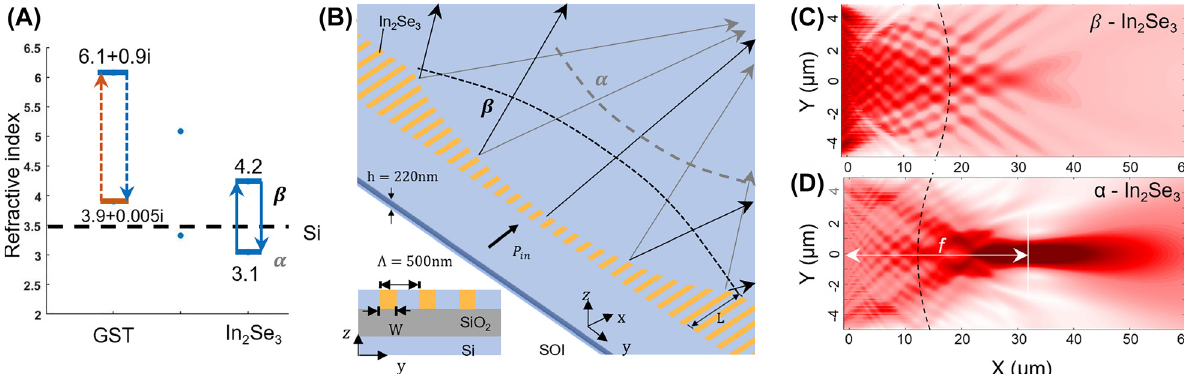
Figure 6: Phase change material embedded silicon photonic metalens [88]. (A) Refractive index comparison for the nonvolatile PCM materials at inter-convertible states/phase. (B) Perspective view of the PCM metalens on silicon photonic platform. For parallel light input, the wavefront of the transmitted wave is convex for 𝛼 -state and concave for 𝛽 -state. Arrows are the propagation directions, and the curves are the wavefronts of the transmitted light. Inset: cross-sectional view of the device. (C) Electrical intensity distribution for a metalens with 𝛽 -In Se , and (D) 100% 𝛼 -In Se . The dashed curves are the wavefronts. 2 3 2 3